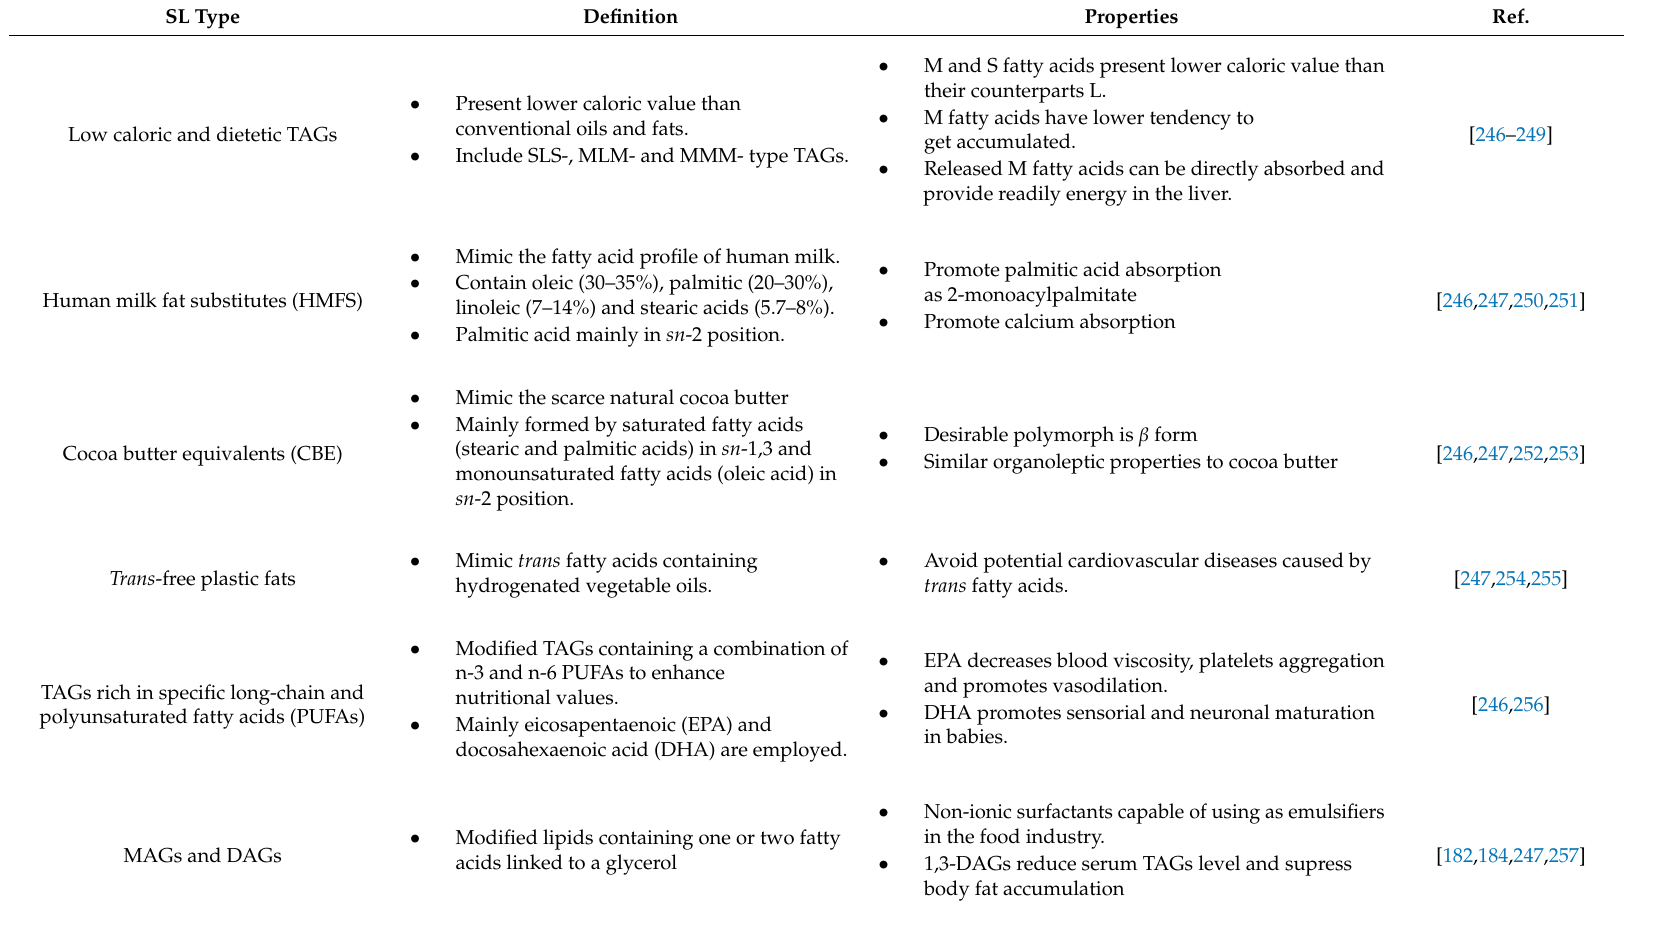
Table 6. Definition and properties of the main commercially relevant structured